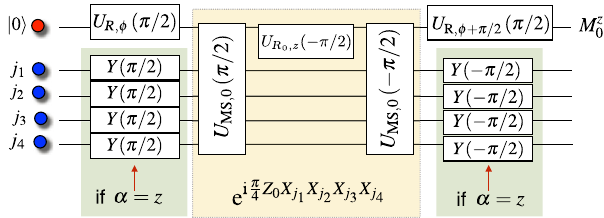
FIG. 5. Stabilizer readout based on multiqubit MS gates: The yellow box contains two five-ion MS gates, interspersed by a single-qubit rotation of the ancillary qubit around the Z axis. This sequence realizes a coherent mapping of the þ 1 = − 1 eigenvalue information of X -type stabilizers [Eq. (23)] onto two orthogonal states of the ancilla qubit (red dot), initially prepared in a superposition state on the equator of the Bloch sphere. Note π = 2 Þ required to prepare that the basis of the initial rotation U R; ϕ ð the ancilla qubit in this way, specified by the angle ϕ , can be π = 2 Þ of the ancilla arbitrary as long as the final rotation U R; ϕ þ π = 2 ð is shifted by π = 2 . In other words, the relative phase between these two single-qubit pulses on the ancilla needs to be well defined, but there does not need to be a fixed phase reference between the addressed laser, driving resonant single-qubit rotations, and the lasers driving global rotations and the entangling MS gate. For the readout of Z -type stabilizers [Eq. (23)], the data qubits must be rotated via Y ð(cid:3) π = 2 Þ at the beginning and at the end of the mapping, to effectively switch between X - and Z -type